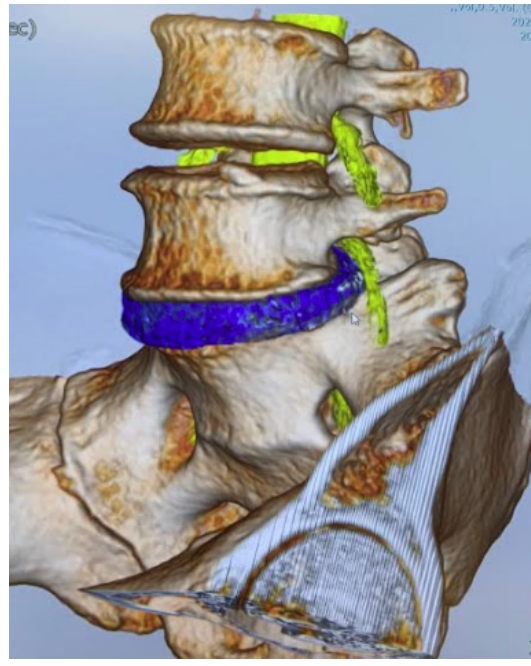
Figure 2. MRI and CT medical image fusion.